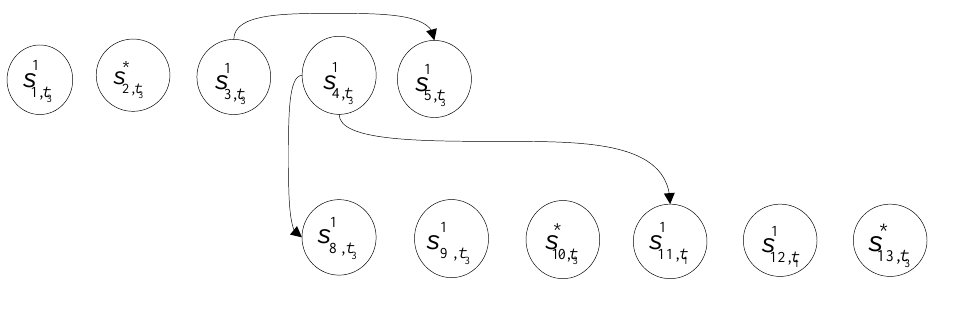
Figure 2. The execution impact graph G 2 formed when Program 1 is executed by test case 2.